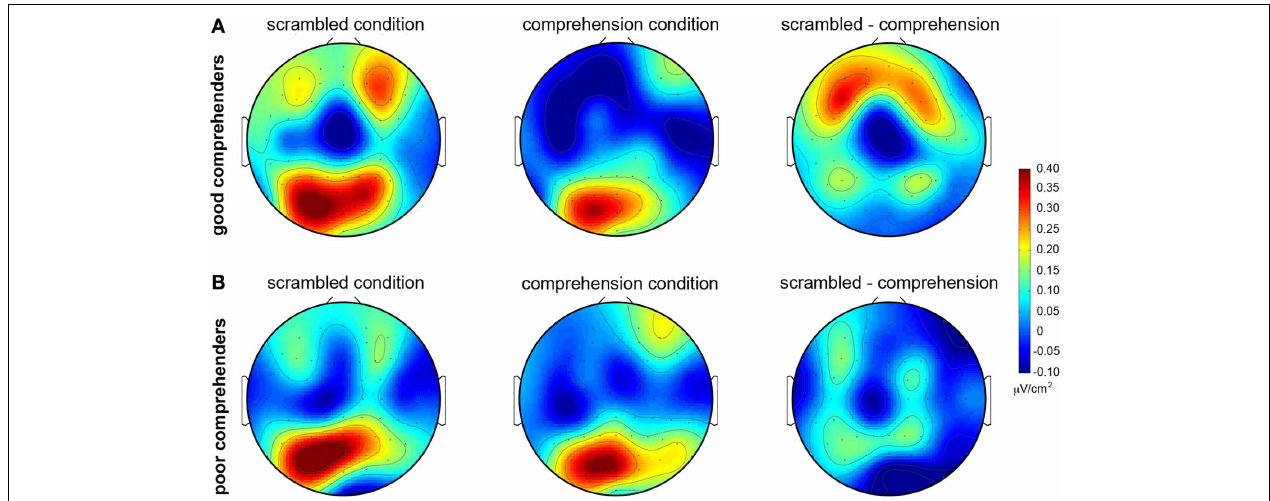
FIGURE 4 | Topographic maps of mean CSD-transformed ERPs during 400–500ms post-target-word-onset in the scrambled and comprehension conditions. (A) For good comprehenders. (B) For poor comprehenders. Warm and cool colors indicate current sources and sinks, respectively (see the color bar to the right of the